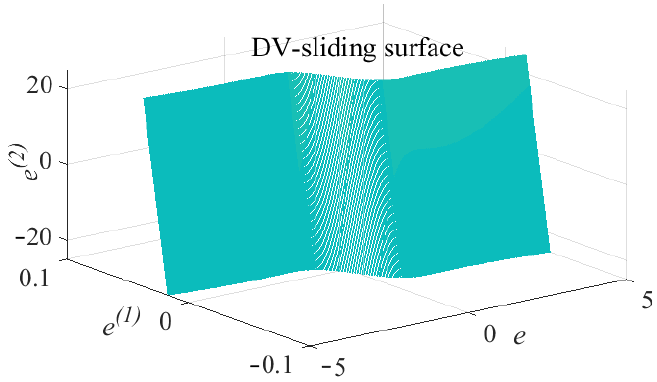
Figure 2. Diagram of damping variable (DV) sliding surface.